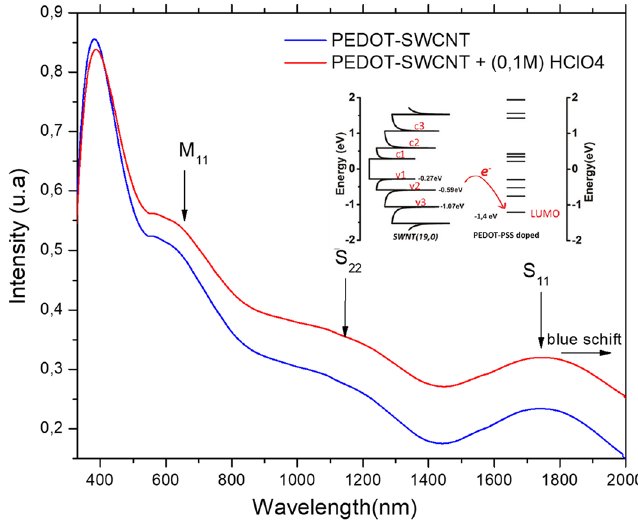
Figure 5. Optical absorption spectra for PEDOT-SWNTs and PEDOT-SWNTs doped with HClO 4 showing the p-doping effect of PEDOT-SWNTs due to the use of (0.1 M) HClO 4 , which leads to a small blueshift, and the inserted schema illustrate the electron transfer from the SWNTs to